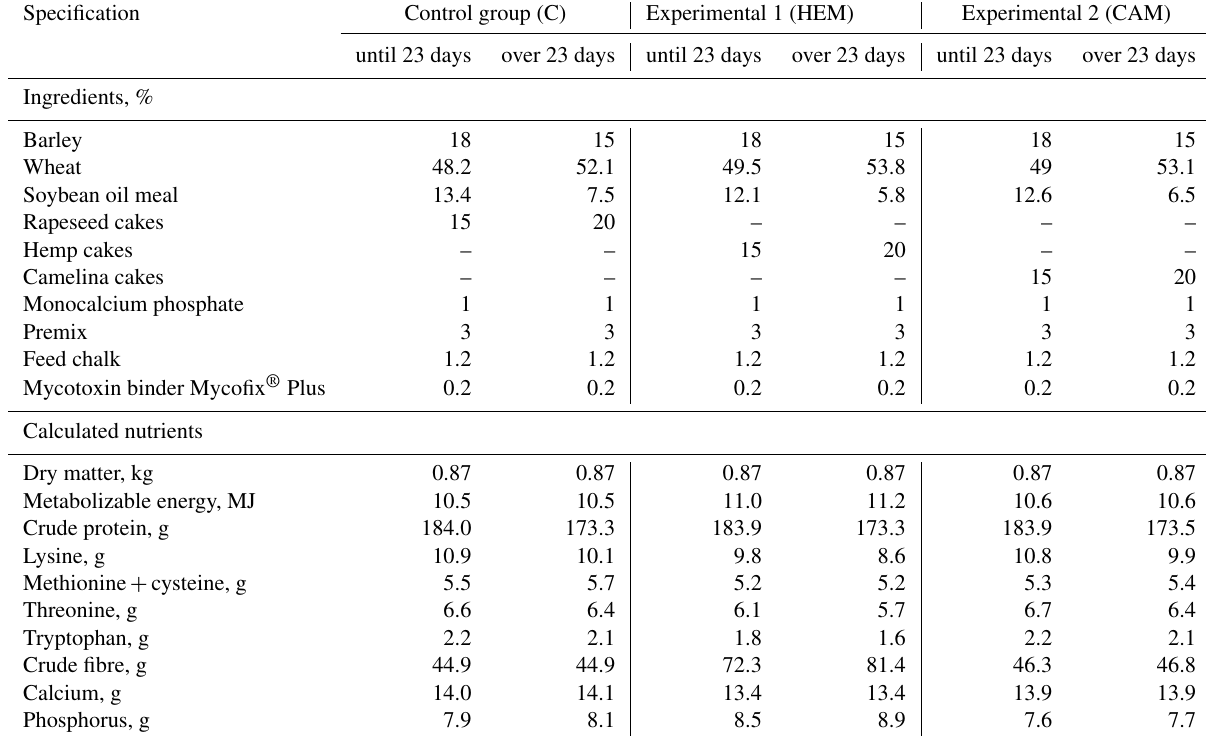
Table 1. Diet composition used in the trial.